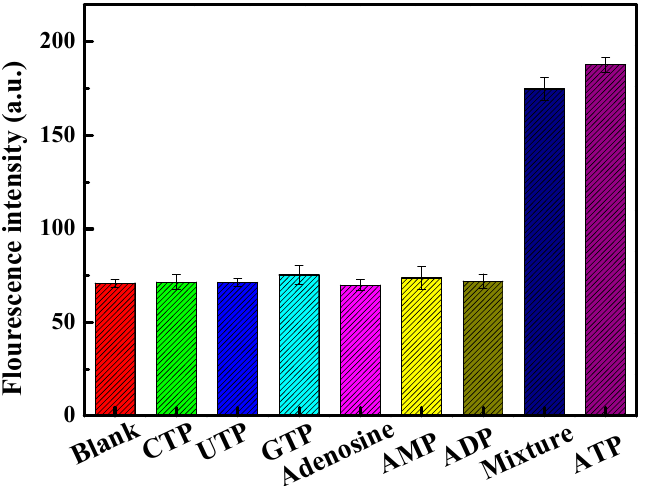
Figure 4. Selectivity of the assay for the detection of ATP. The mixture consists of ATP, CTP, UTP, GTP, adenosine, AMP, ADP, each in concentrations of 200 nmol/L.